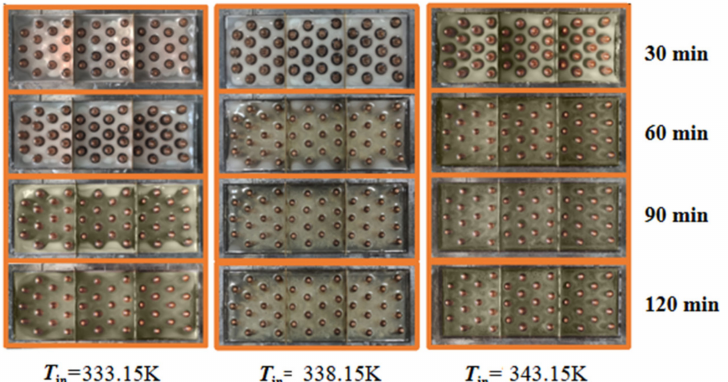
Figure 8. Melting of paraffin on the upper surface of phase change heat storage for CASE4 at different T in .